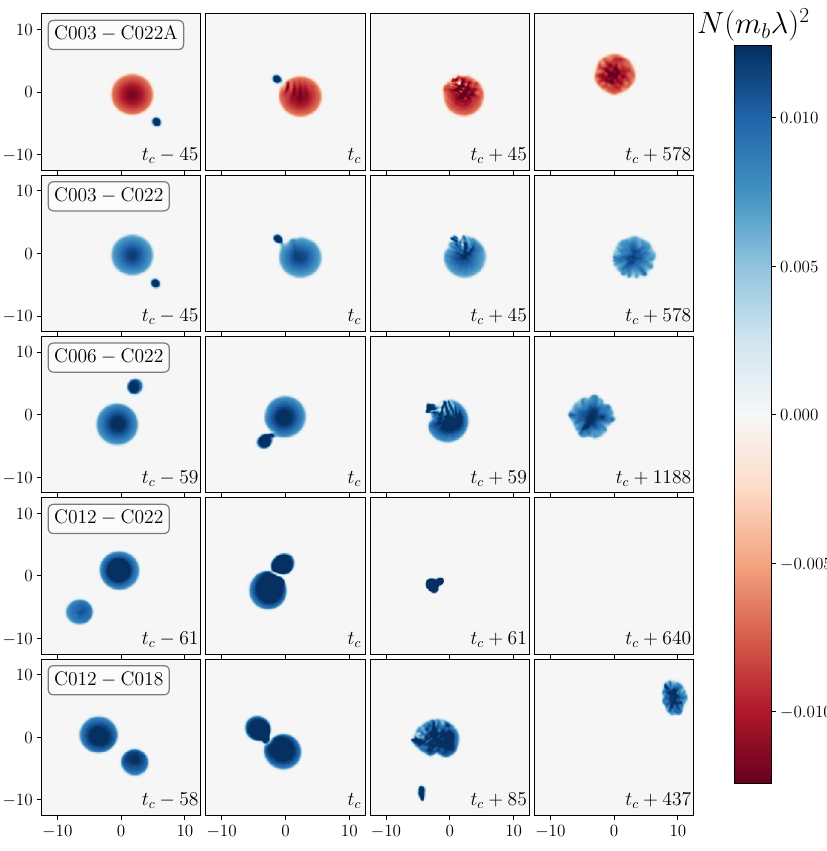
Fig. 28 Snapshots from the mergers of four different, unequal mass, solitonic BS binaries (similar to Fig. 27 which shows only equal mass binaries). Displayed is the Noether charge density on the orbital plane before and after the contact time, t c . The top two rows consist of a star with compactness 0.03 paired with one with compactness 0.22, but the top row begins with the compact star having the opposite charge from its stellar pair. For this case, the small star is annihilated, leaving a less massive remnant. Continuing downward, the next row has stars with compactnesses 0.06 and 0.12, followed by 0.12 paired with 0.22 and with 0.18. Note that this fi nal case ejects a single scalar blob in contrast to the pair of blobs ejected in the second row of Fig. 27. Reproduced with permission from Bezares et al. (2022), copyright by